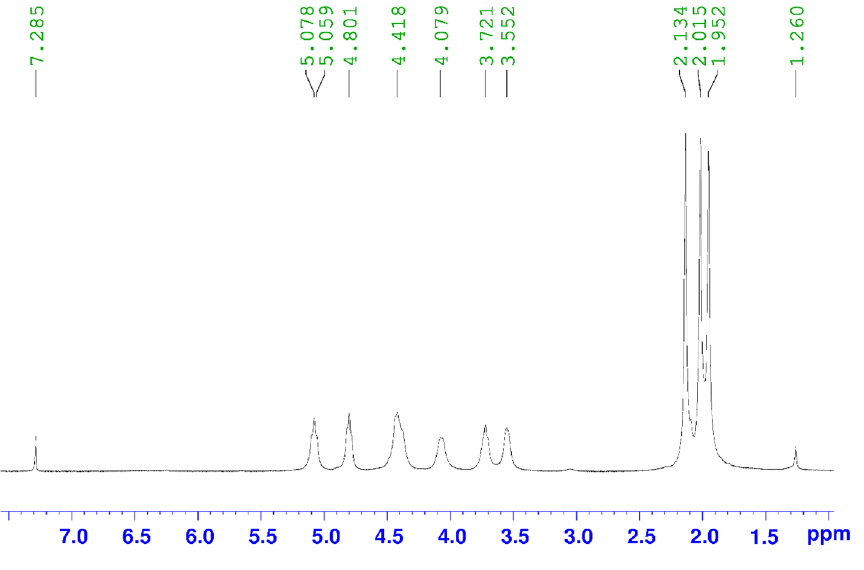
Figure 4. 1 H-NMR spectrum of Sample 5.